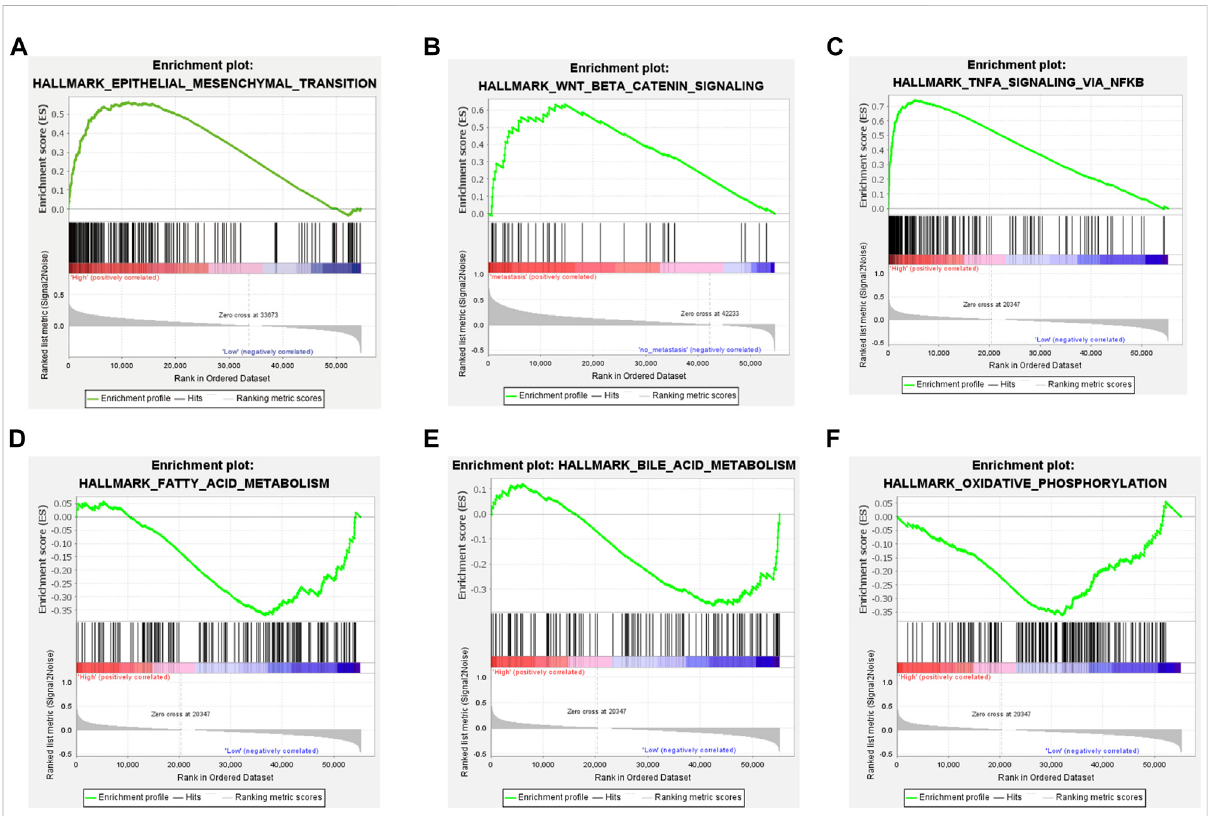
FIGURE 5 TM4SF1facilitatesepithelial-mesenchymaltransitioninPTCbasedonGSEA. (A) Epithelial-mesenchymaltransitionpathway; (B) Wnt/ β -Catenin pathway; and (C) TNFA signal via NFKB pathway enriched in TM4SF1 high expression group; and (D) Fatty acid metabolism pathway; (E) Bile acid metabolism pathway; and (F) Oxidative phosphorylation pathway enriched in TM4SF1 low expression